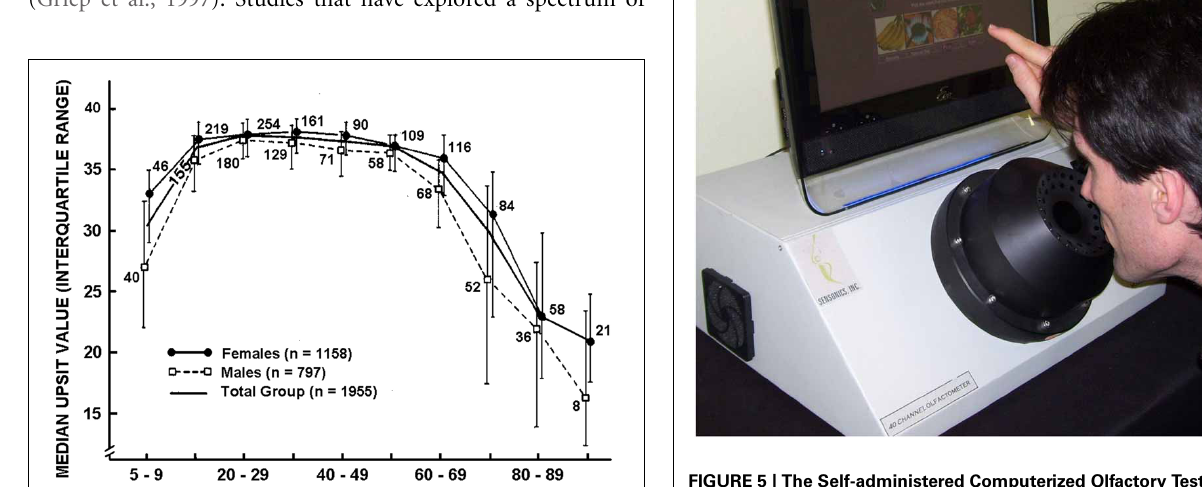
FIGURE 5 | The Self-administered Computerized Olfactory Testing System (SCOTS). This modern olfactometer allows for self-administration of olfactory threshold tests, among other types of tests, and automatically calculates the threshold value based upon subject responses. This system eliminates administrator error in the presentation of test stimuli and provides exacting control of stimulus duration, inter-stimulus intervals, and other factors. Photograph courtesy of Sensonics International, Haddon Heights, New Jersey USA. Copyright©2013, Sensonics International.